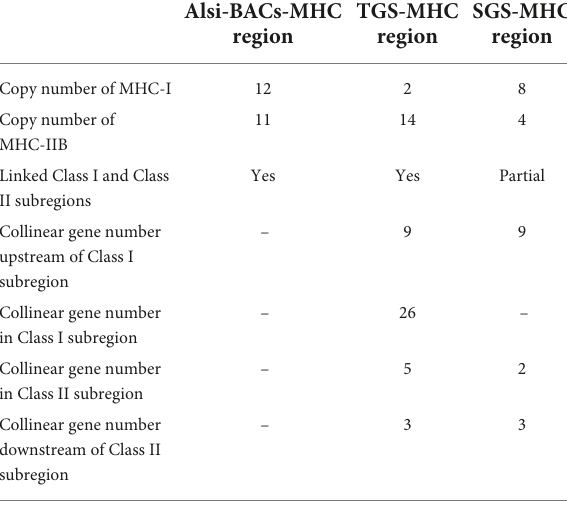
TABLE 1 Comparison of MHC region from three sources.